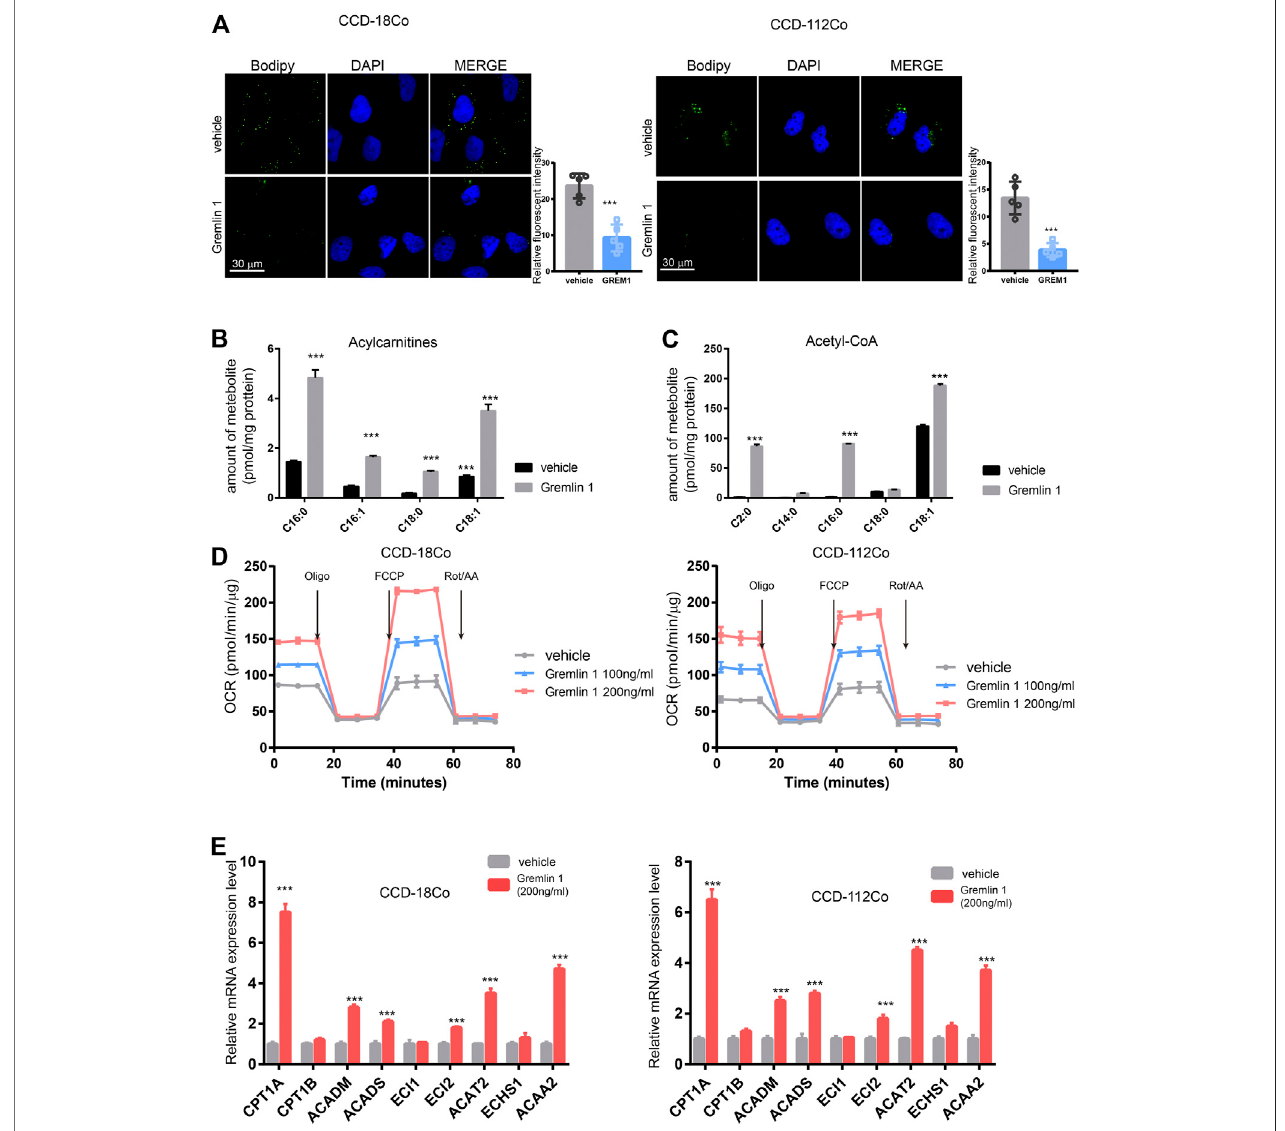
FIGURE3| Gremlin1facilitytheFAOofintestinal fi broblastcell. (A) .Bodipyassayofhumanintestinal fi broblastcellsCCD-18CoandCCD-112Cocellsthattreated with 200 ng/ml Gremlin 1 for 24 h or not. Relative fl uorescent intensity was calculated of fi ve random fi elds of slides (B, C) . The amount of representative individual lipid species, lipid droplets degraded production, Acylcarnitines (B) and Acetyl-CoA (C) in human intestinal fi broblast cells CCD-18Co and CCD-112Co cells treated with 200 ng/ml Gremlin 1 for 24 h or not. The amounts of acylcarnitine and acetyl-CoA (were normalized to the total protein of fi broblast cells. (D) . The measurement of OCRin human intestinal fi broblast cellsCCD-18Co and CCD-112Co cells treated with200 ng/mlGremlin 1for 24 h or not. (E) . Q-PCR results of theFAO related genes expression in human intestinal fi broblast cells CCD-18Co and CCD-112Co cells treated with 200 ng/ml Gremlin 1 for 24 h or not. These experiments were repeated twice p values are derived from two-sided Student ’ s t test. ** p ≤ 0.01; *** p ≤ 0.001.